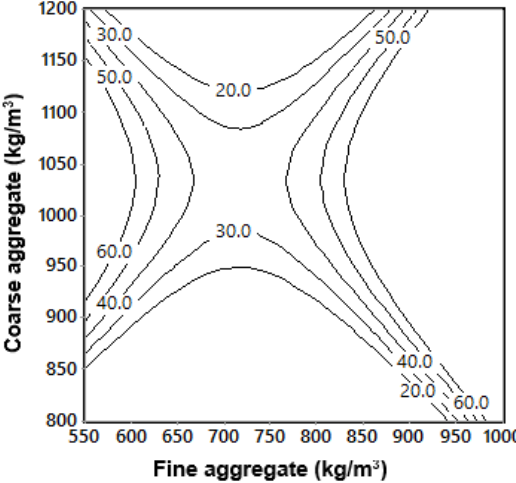
Figure 11. Isoresponse contours for modulus of elasticity of SFRC.